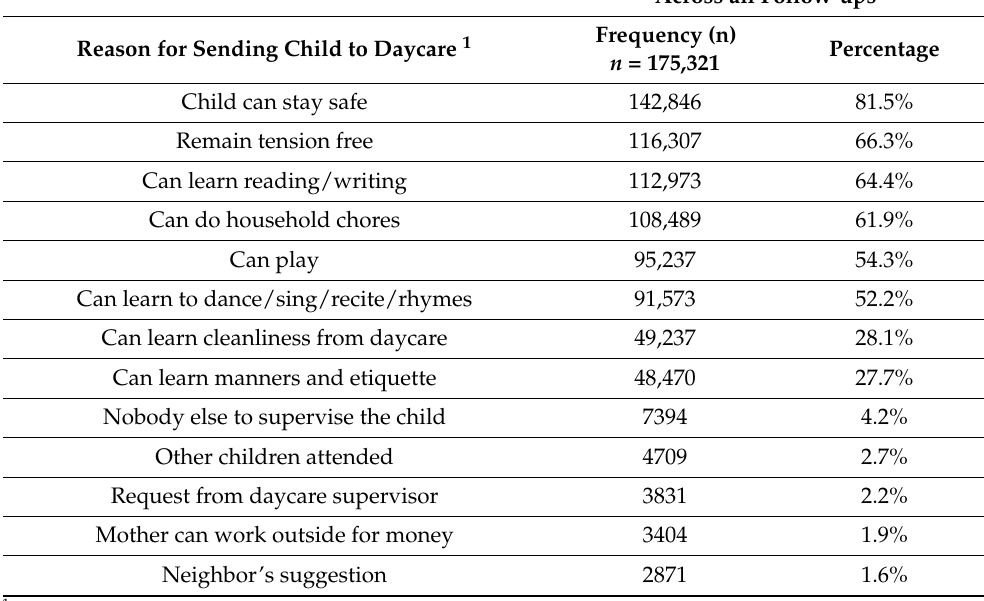
Table 2. Reasons for sending a child to a daycare.